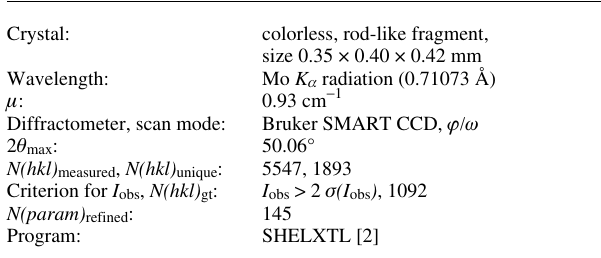
Table 1. Data collection and handling.